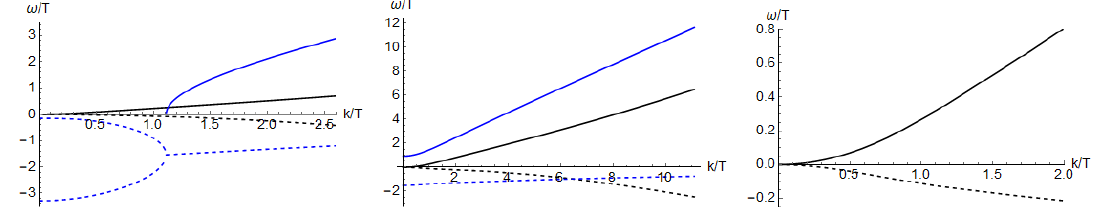
Figure 6 . The transverse collective modes in presence of transverse phonons. Dispersion relations as functions of the shear elastic modulus of the system G , encoded in the dimensionless parameter (cid:11) 3 =T . Solid lines are the real parts, dashed lines the imaginary parts. Similarly colored dashed and solid lines correspond to the same mode. Left: intermediate chemical potential, (cid:22)=T = 1, and (cid:11) 3 =T = 1. Center: large chemical potential, (cid:22)=T = 3, and (cid:11) 3 =T = 3. Right: zoom on the transverse phonon mode in the center